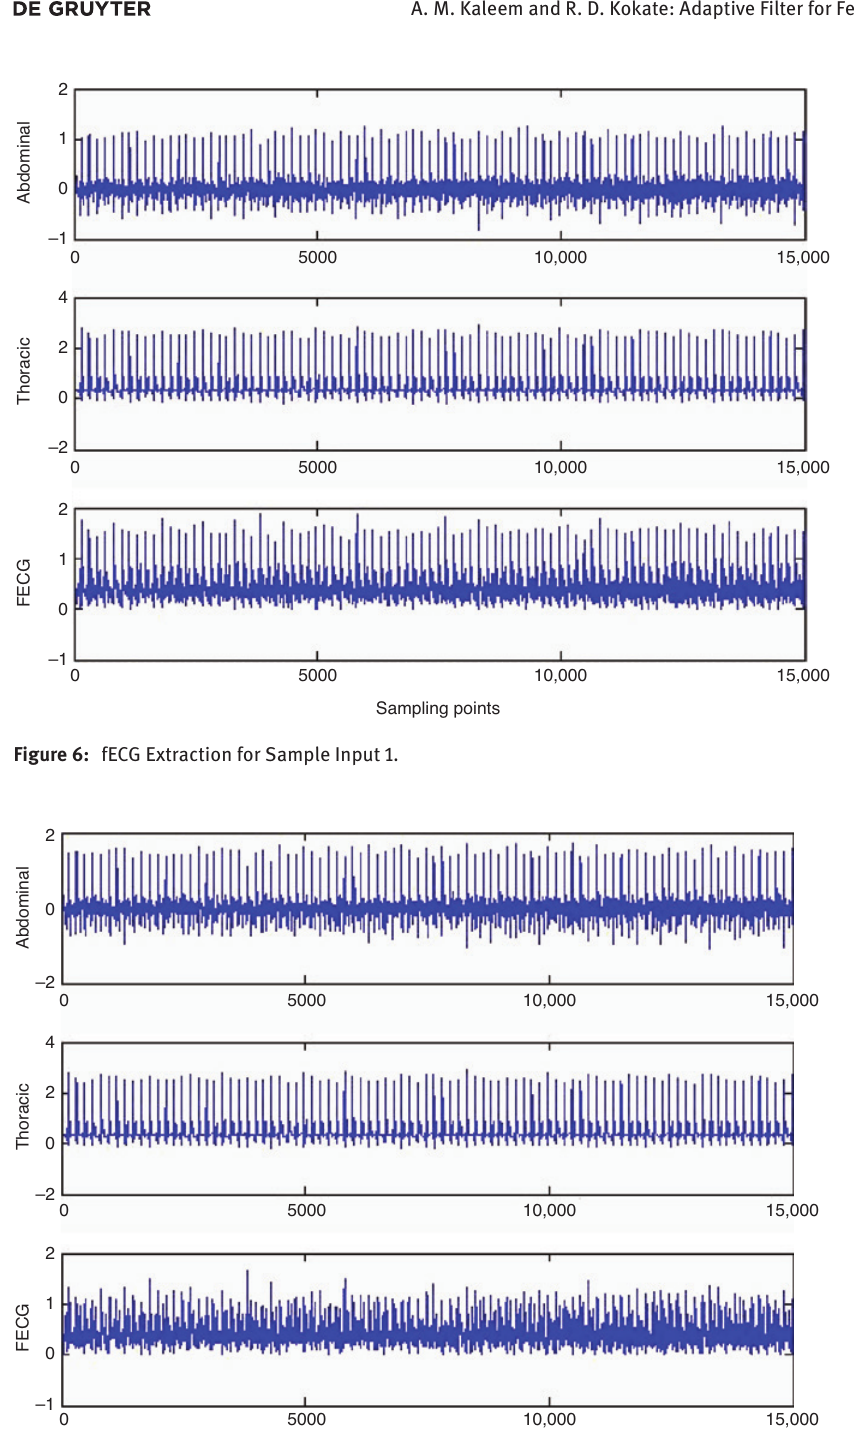
Figure 7: fECG Extraction for Sample Input